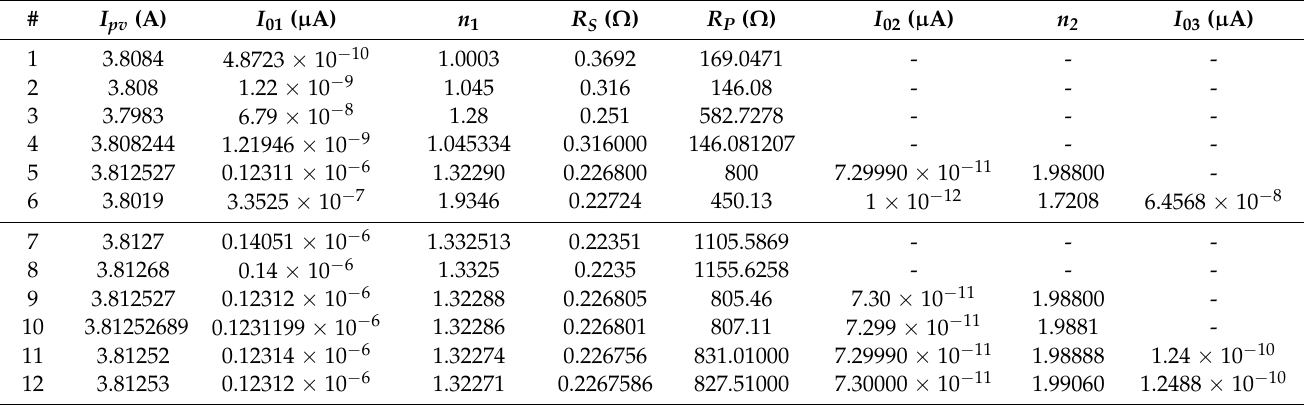
Table 4. Parameters of the equivalent circuit models of the Solarex MSX–60 module using the methods presented in Table